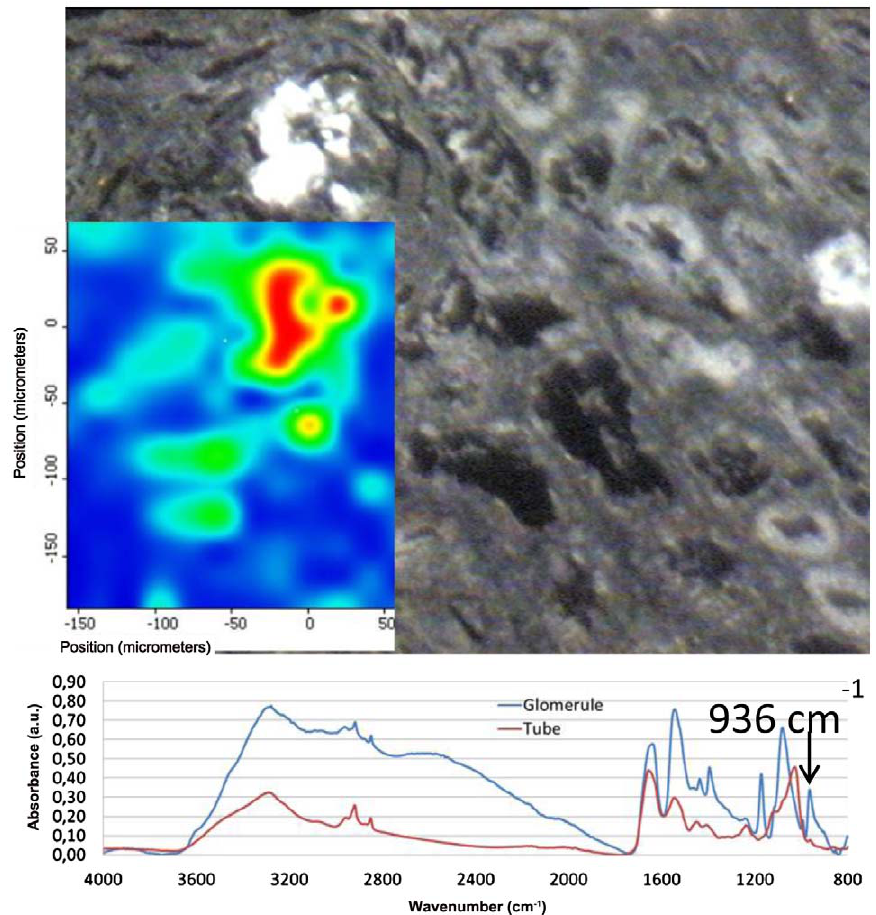
Figure 3. Mapping and optical image of a birefringent structure. The poorly soluble foscarnet can be detected and quantified after a mapping of the biopsy thanks to the characteristic peak at 936 cm -1 .